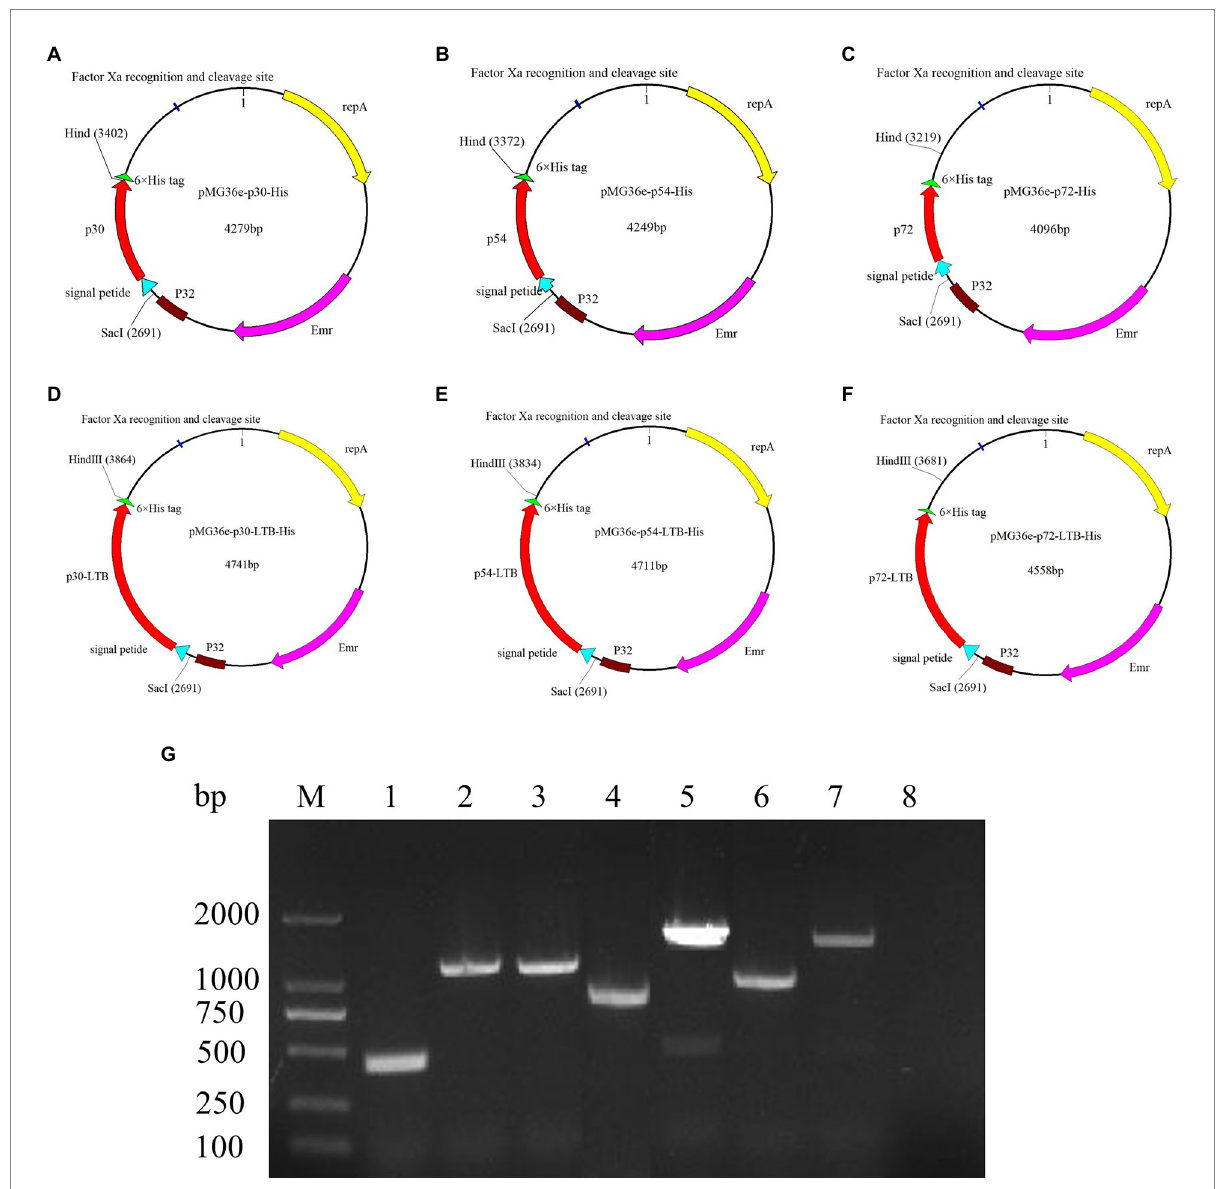
FIGURE 2 Construction and identification of the recombinant L. lactis . (A) A map of the plasmid pMG36e-p30-His, the plasmid size is 4,279 bp; (B) A map of the plasmid pMG36e-p54-His, the plasmid size is 4,249 bp; (C) A map of the plasmid pMG36e-p72-His, the plasmid size is 4,096 bp; (D) A map of the plasmid pMG36e-p30-LTB-His, the plasmid size is 4,741 bp; (E) A map of the plasmid pMG36e-p54-LTB-His, the plasmid size is 4,711 bp; (F) A map of the plasmid pMG36e-p72-LTB-His, the plasmid size is 4,558 bp. (G) Identification results of recombinant L. lactis by colony PCR, MG1363/ pMG36e (lane 1); MG1363/pMG36e- p30 -His (lane 2); MG1363/pMG36e- p54 -His (lane 3); MG1363/pMG36e- p72 -His (lane 4); MG1363/pMG36e- p30 -LTB-His (lane 5); MG1363/pMG36e- p54 -LTB-His (lane 6); MG1363/pMG36e- p72 -LTB-His (lane 7); Negative control (lane